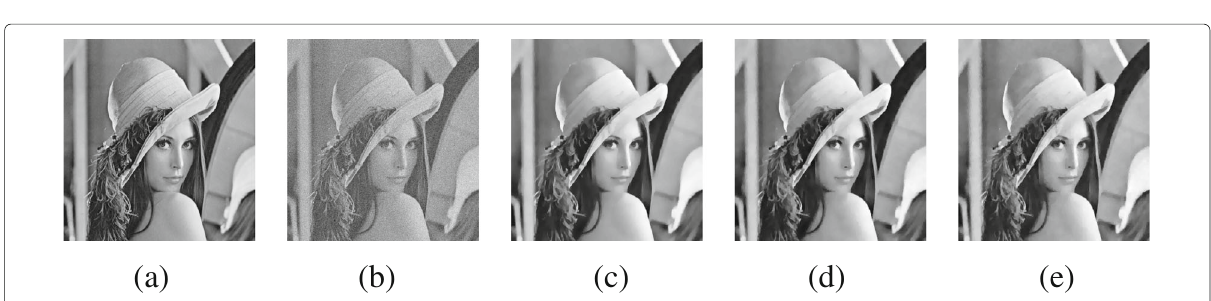
Fig. 13 Denoised results on Lena a original image; b Lena image corrupted with Gaussian noise with σ = 20; c restored image by optimal value of c = 1.69; d restored image by c = 1.78; ( e ) restored image by c =